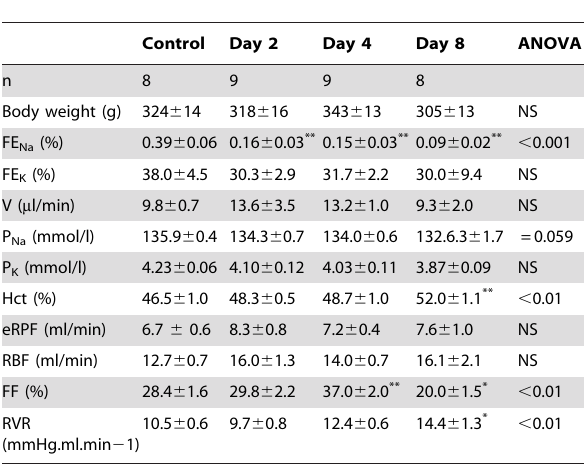
doi:10.1371/journal.pone.0036311.t001